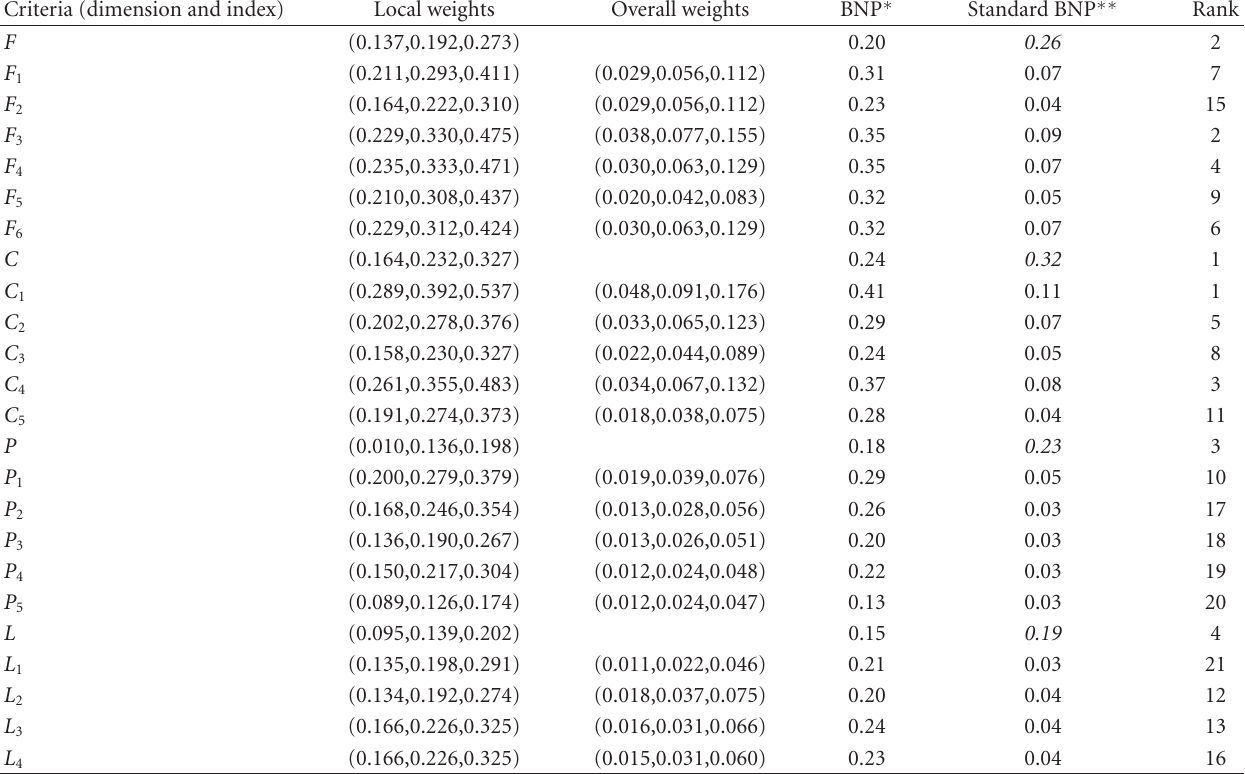
Table 2: fuzzy weight of BSC performance indexes by